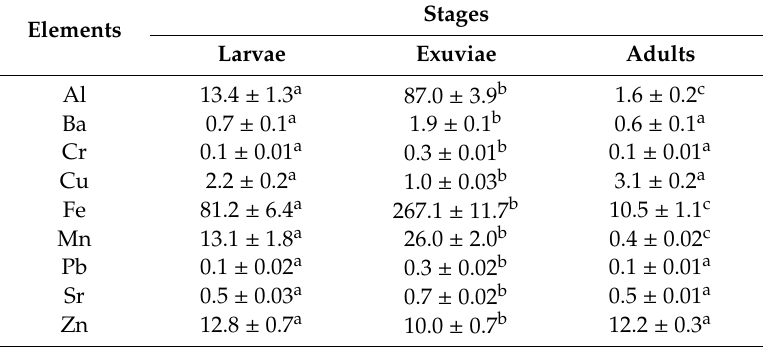
Table 1. Trace element contents per individual (expressed as mean ± standard error unit: µ g) of G. flavipes developmental stages in the Tuzs é r studied area. Notations: di ff erent letters indicate the significant di ff erences at p < 0.05.